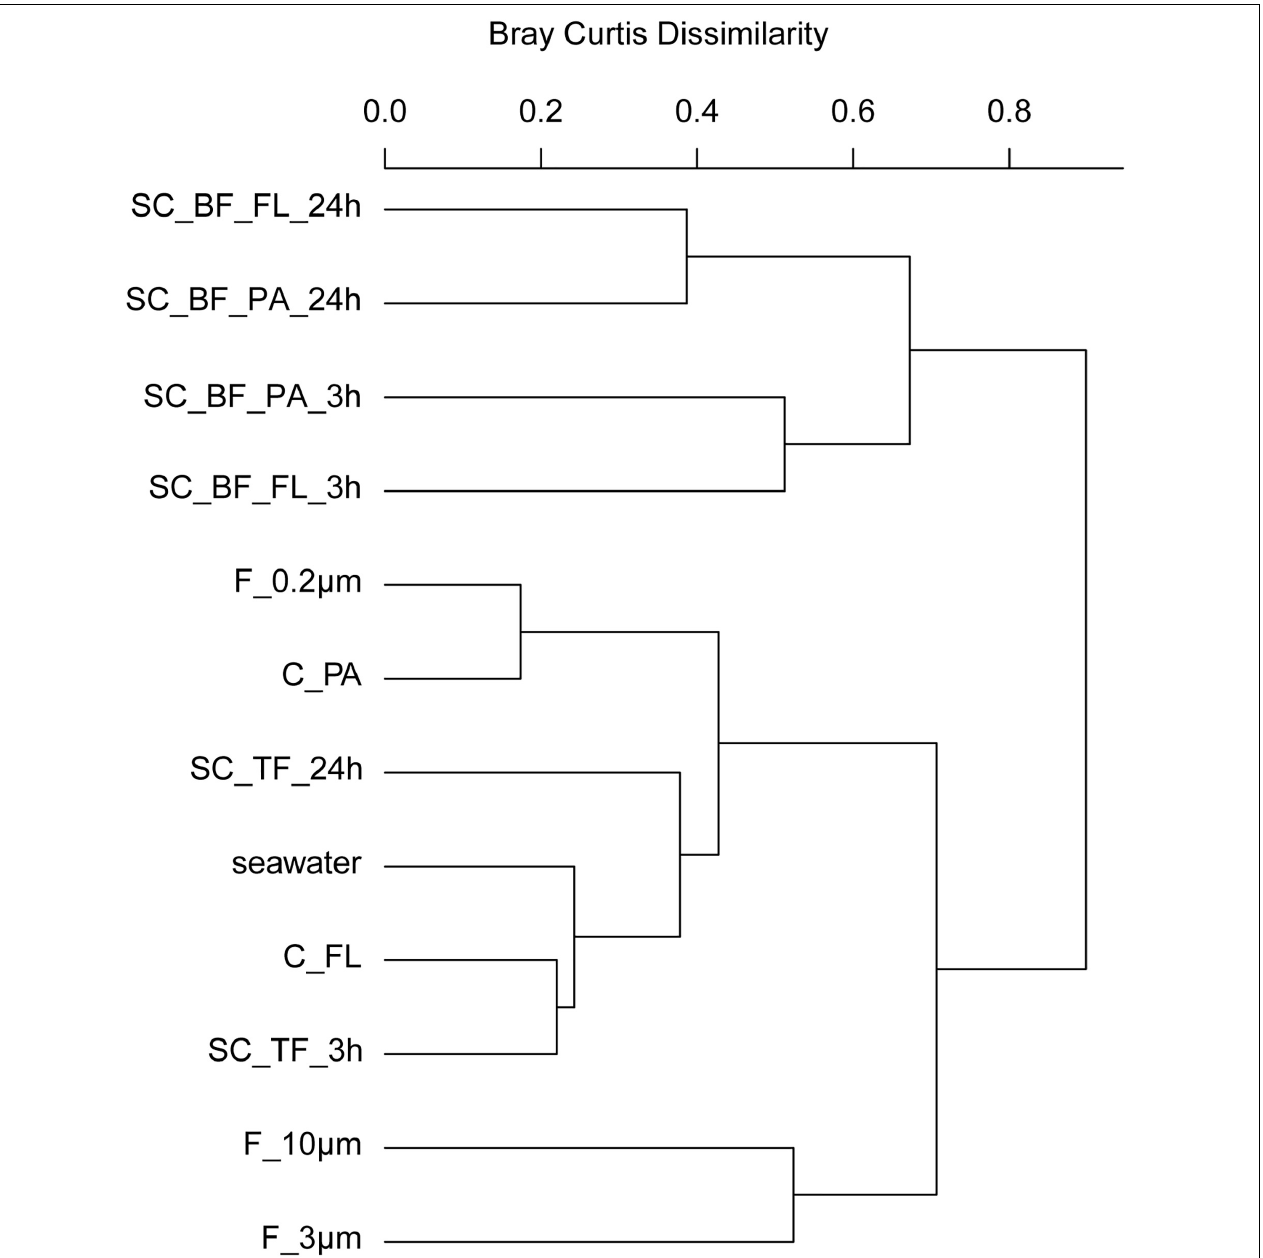
FIGURE 6 | Community composition shifts by variable settlement times (3 and 24 h). Cluster tree based on Bray–Curtis dissimilarity depicting bacterial communities obtained during a phytoplankton spring bloom off Helgoland (North Sea) in 2018. Seawater was fractionated applying sequential filtration with 10-, 3-, and 0.2- µ m pore-sized filters (F_10 µ m, F_3 µ m, and F_0.2 µ m, respectively), using centrifugation to obtain a supernatant (C_FL) and pellet fraction (C_PA) or by sedimentation in cones (SC). The SC samples were composed of a free-living fraction (SC_TF), and a bottom fraction that was resuspended in artificial seawater and secondarily split by centrifugation into a supernatant (SC_BF_FL) and pellet (SC_BF_PA). Sedimentation times were either 3 or 24 h. All other samples were immediately processed ( t = 0 h). A reference sample was taken by filtering seawater directly onto a 0.2- µ m filter